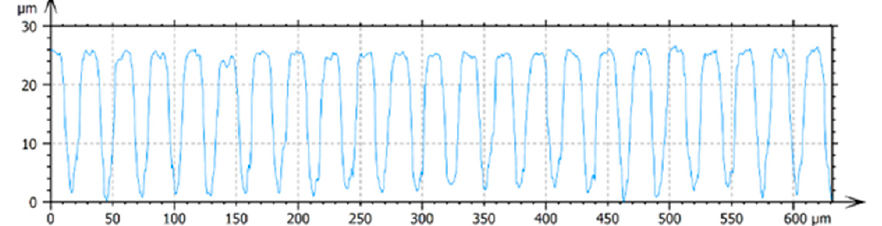
Figure 8. Interferometric image obtained with the MountainsMap software. This sample is the one for which the square pillars’ top was not irradiated.